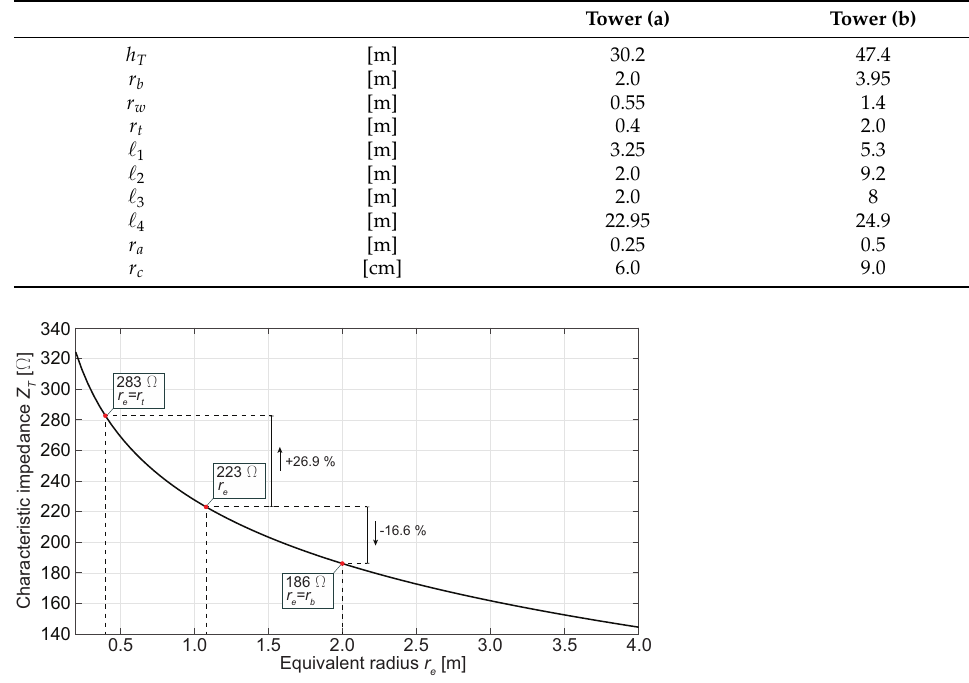
Figure 17. Variability in the characteristic impedance, computed for tower (a) in Figure 16 ( h T = 30.2 m, rated voltage 132 kV) according to the revised Jordan formula in Section 4.1.1, with the choice of the tower equivalent radius r e